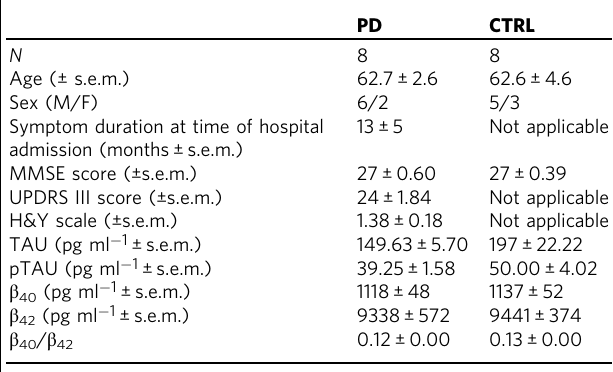
See Supplementary Table 1 for additional